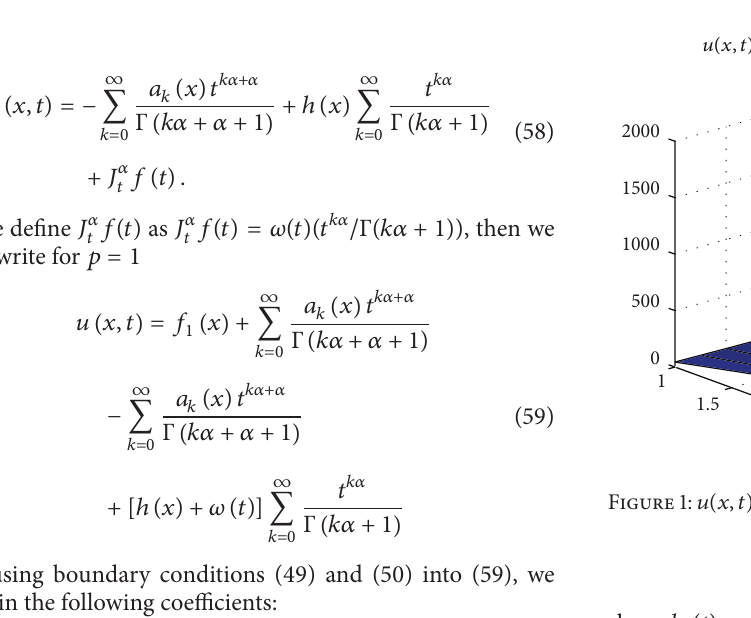
where ℎ 1 (𝑡) and ℎ 2 (𝑡) ∈ 𝐶 ∞ [0, ∞) and ℎ(𝑥), 𝑓 1 (𝑥) , and 𝑓(𝑥) ∈ 𝐶 ∞ [0, ∞)